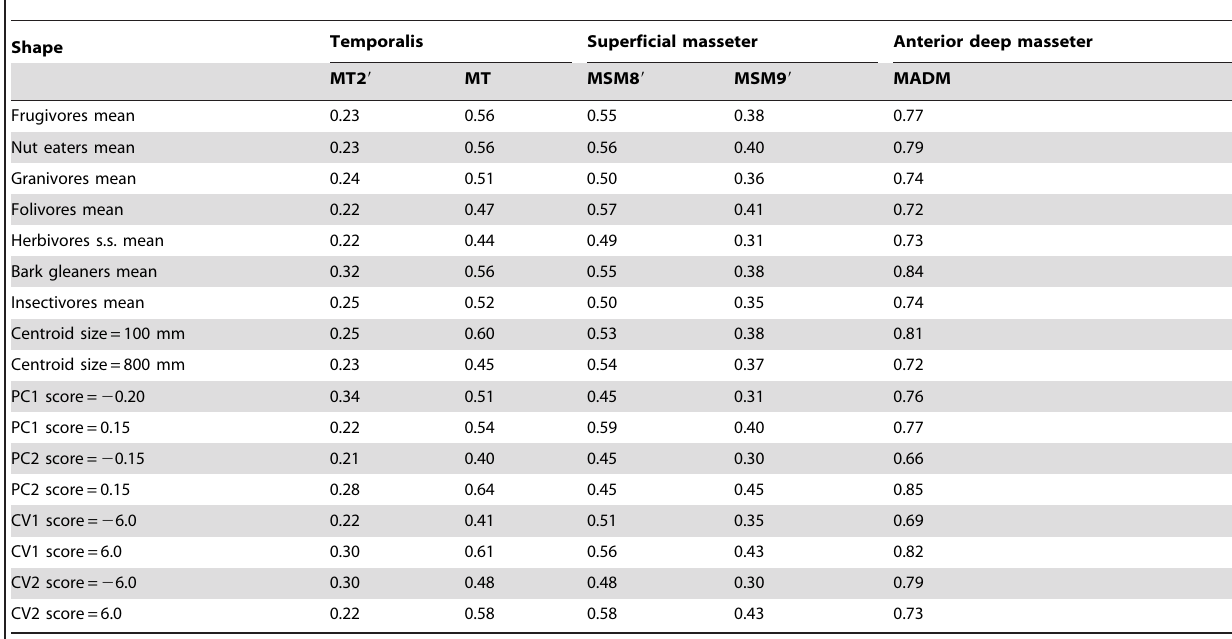
Table 2. Mechanical advantage of main mandibular muscles expressed as ratios of moment arms to incisor resistance arm for mean shapes of dietary